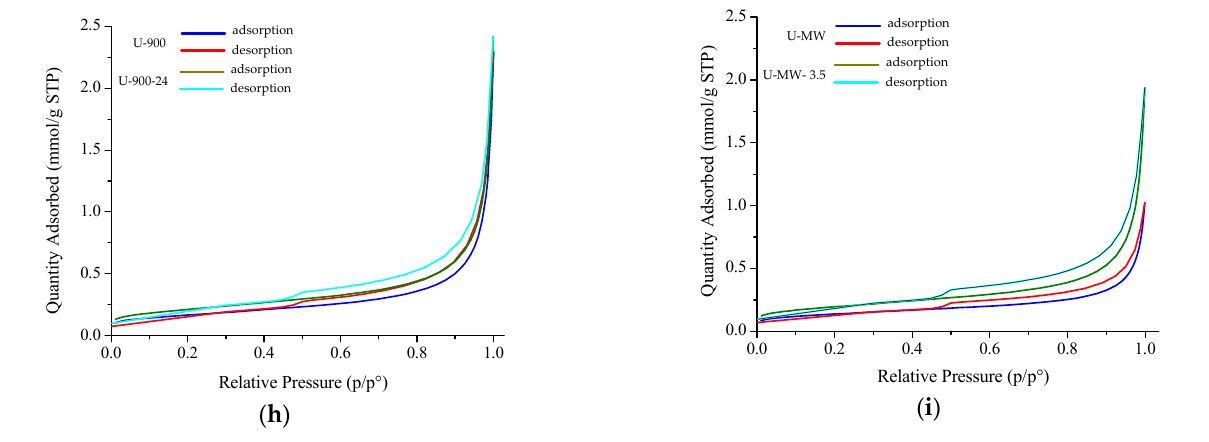
Figure 8. Nitrogen adsorption–desorption isotherms of raw and treated vermiculites at different temperature: ( a ) 20 °C; ( b ) 300 °C; ( c ) 400 °C; ( d ) 500 °C; ( e ) 600 °C; ( f ) 700 °C; ( g ) 800 °C; ( h ) 900 °C, and microwave irradiated ( i ).